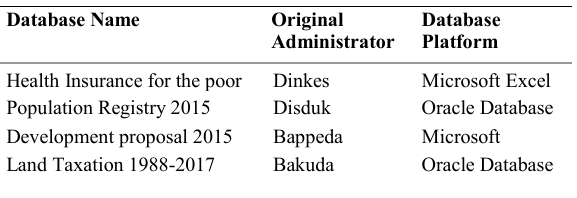
Table 1: Collected databases from local government in Sambas